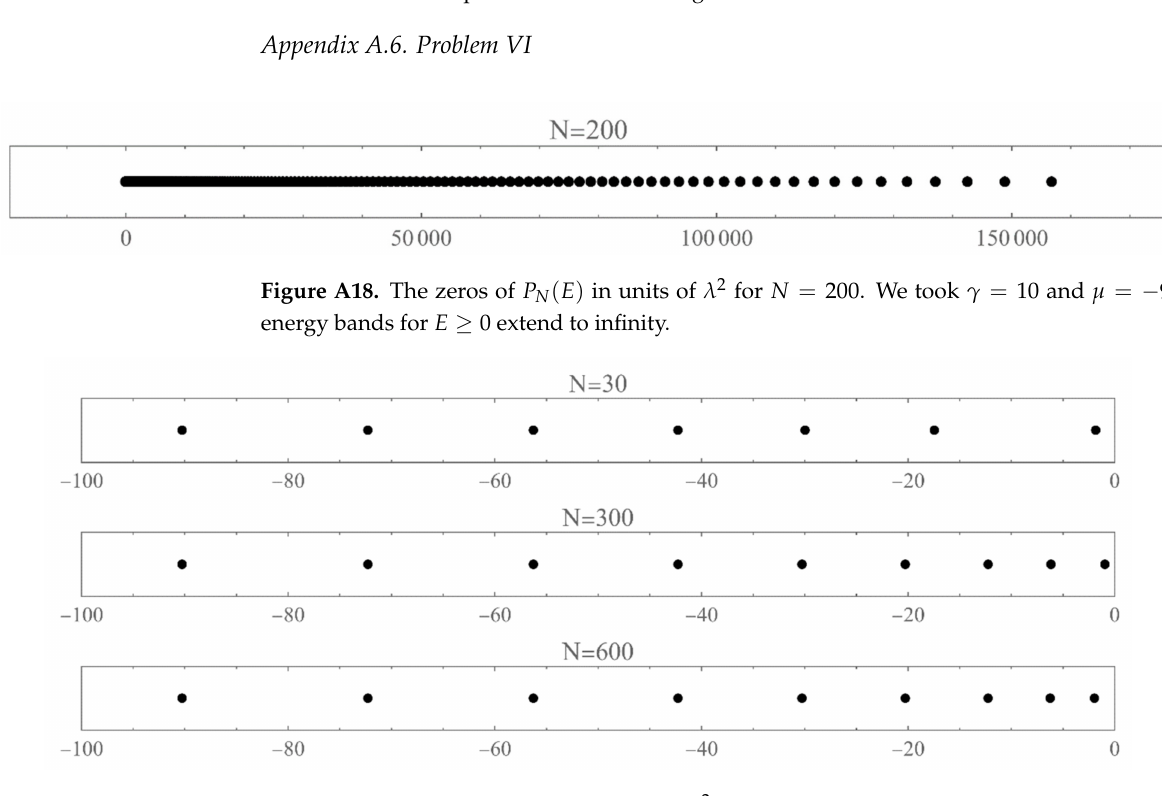
Figure A19. The zeros of P N ( E ) in units of λ 2 for different values of N . The energy bands for E < 0 are found to converge to a discrete linearly spaced